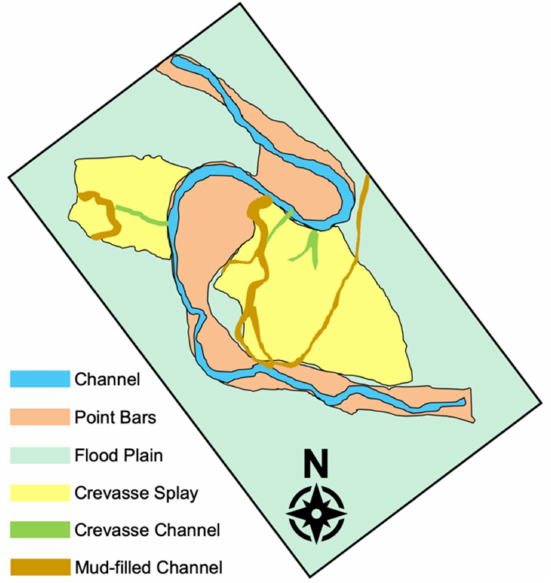
Figure 4. Interpreted model of the fluvial depositional elements map.